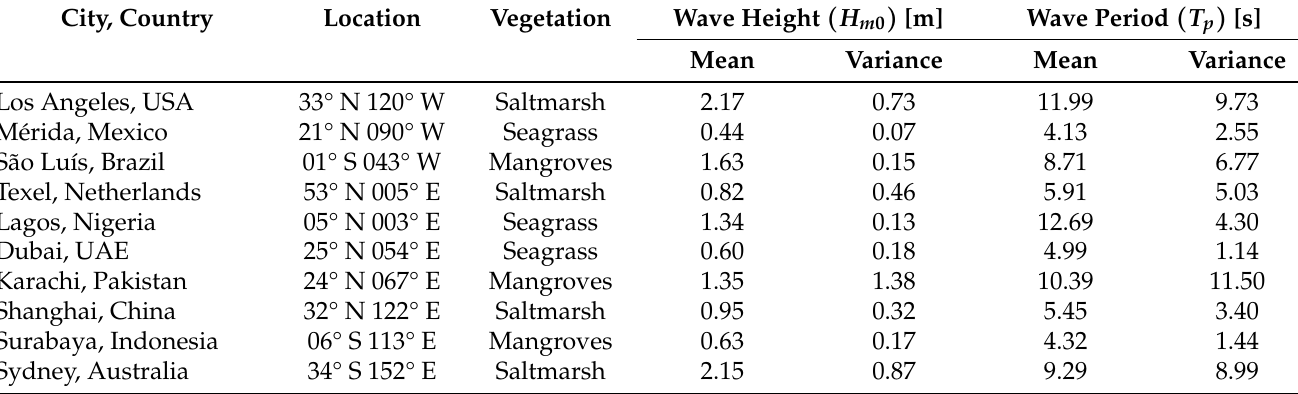
Table 3. World wave climate based on ten cities in biggest deltas having vegetated foreshores. City,